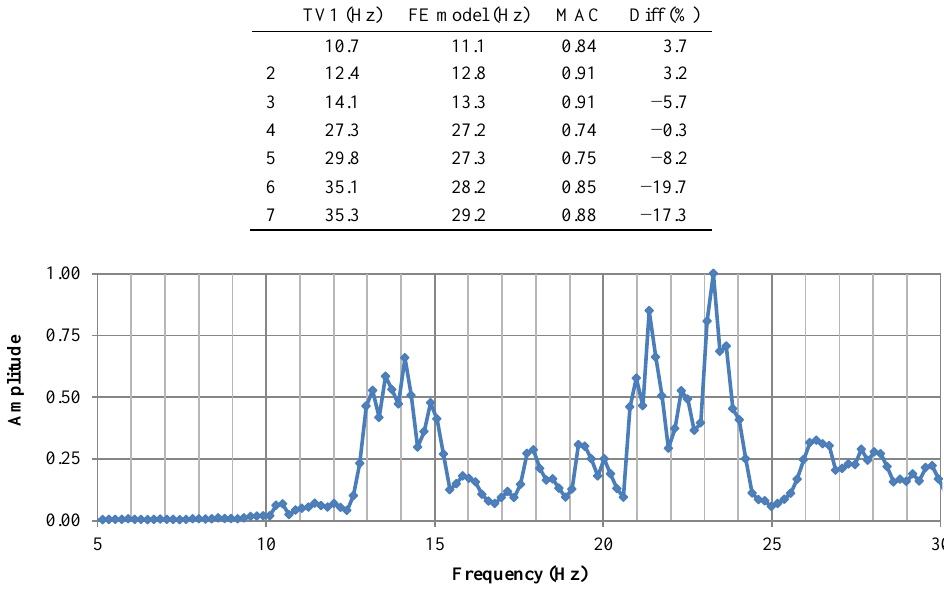
Fig. 6. First singular value plot in the Frequency Domain for TV1.